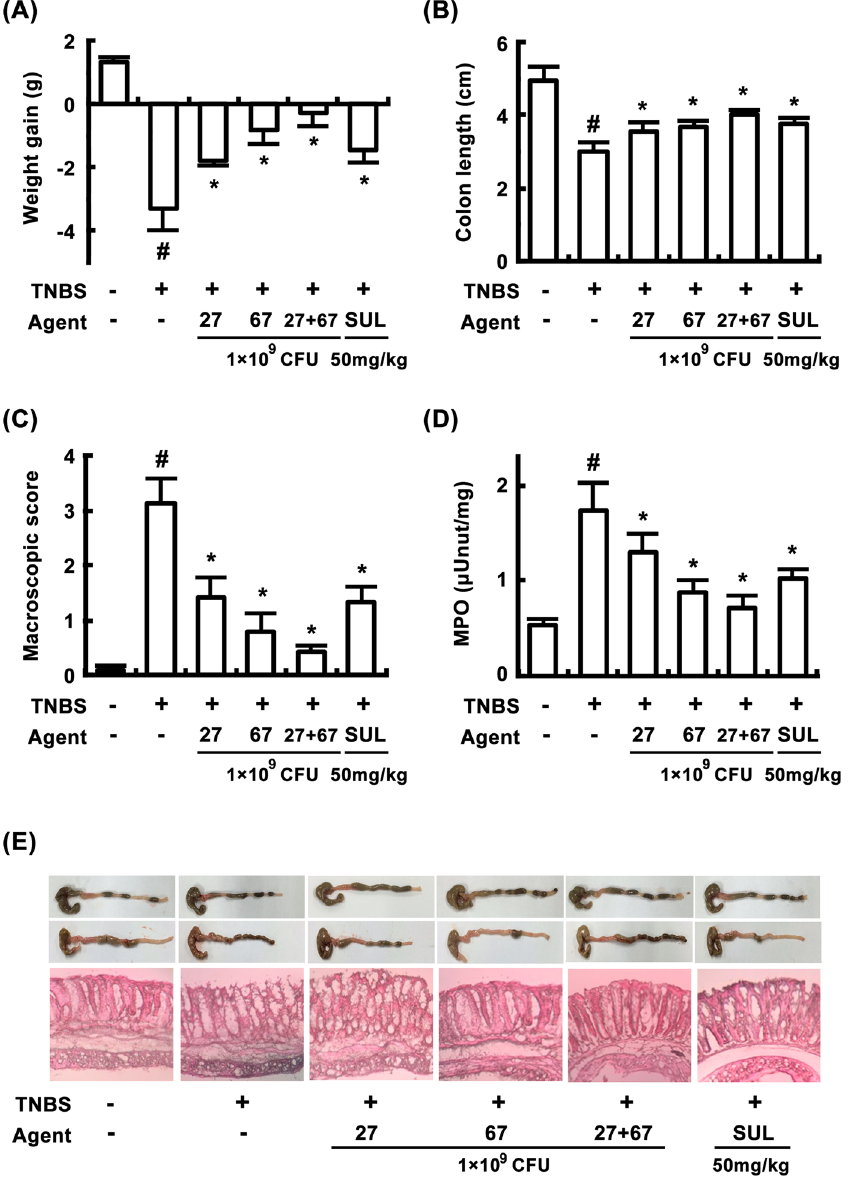
Figure 3. Effects of LC27, LC67, and PM on body weight ( A ), colon length ( B ), macroscopic disease ( C ), colonic myeloperoxidase (MPO) activity ( D ), and histological examination ( E ) in the colon of mice with TNBS-induced colitis. TNBS, except in the normal control group, was intrarectally administered to mice and test agents [saline, LC5, LC27, LC67, LC68 (2 × 10 9 CFU/mouse), or sulfasalazine (SUL; 50 mg/kg)] were orally administered for 3 days. The mice were sacrificed 18 h after the final administration of test agents. All data are shown as the mean ± SD (n = 6). # p < 0.05 vs. normal control group. * p < 0.05 vs. group treated with TNBS